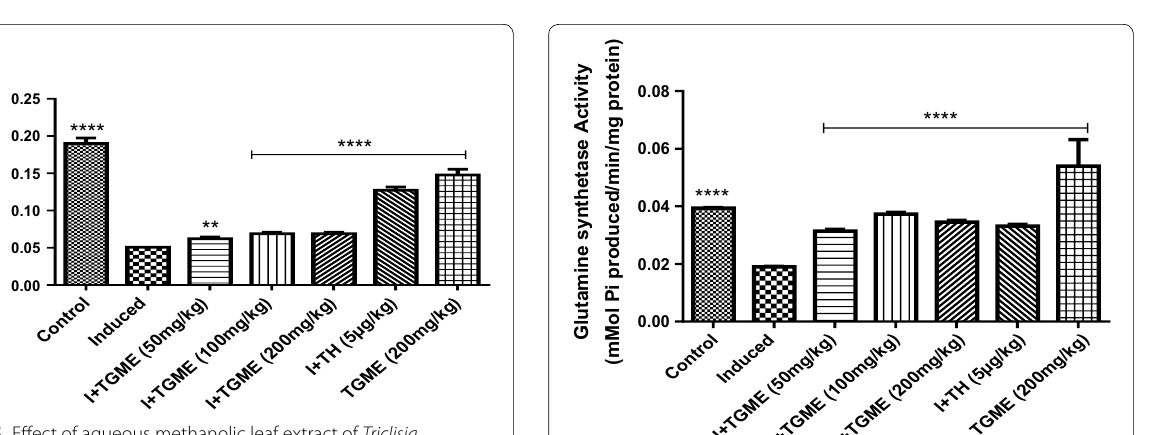
Fig. 15 Effect of aqueous methanolic leaf extract of Triclisia gilletii on complex 1 activity in the kidney of animals administered ethane-1,2-diol. Data are expressed as mean ** p < 0.01, and **** p < 0.0001; *denotes that data were compared with ethane-1,2-diol; TGME Triclisia gilletii aqueous methanolic extract, TH tamsulosin hydrochloride